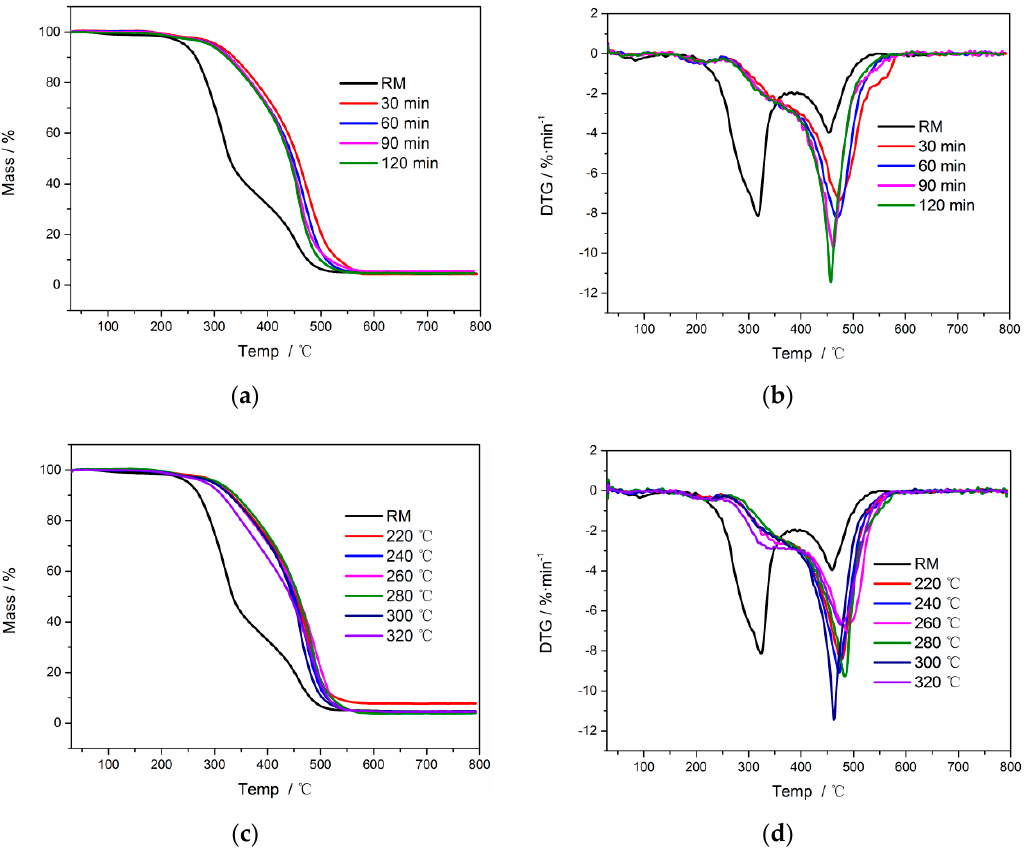
Figure 5. TGA of red jujube branch hydrochar. ( a ) TG of residence time; ( b ) derivative thermogravimetry (DTG) of residence time; ( c ) TG of reaction temperature; ( d ) DTG of reaction temperature. Note: The raw material is abbreviated as RM.